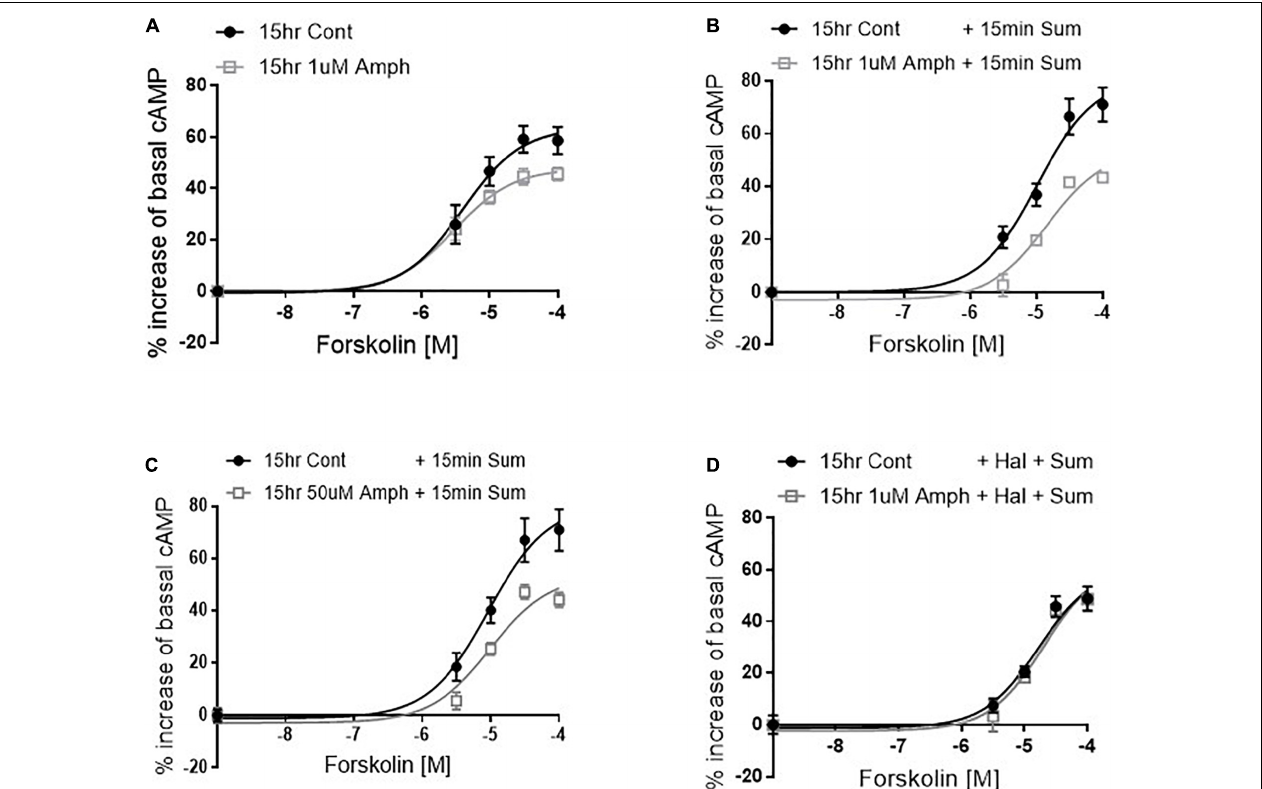
FIGURE 3 | Amphetamine reduces forskolin- and D2R-induced cAMP production. After pretreating cells with control or 1 µ M amphetamine (Amph), cells were treated with increasing concentrations of forskolin (A) . cAMP production was statistically lower in Amph-pretreated samples with respect to controls ( p = 0.006). Parallel samples were treated for 15 min with 100 µ M sumanirole (Sum) after 15-h pretreatment with control, 1 µ M (B) or 50 µ M (C) Amph. Amph significantly reduced cAMP production ( p = 0.0001). Coincubation of 10 nM haloperidol (Hal) with 1 µ M Amph prevented the Sum-induced decrease of cAMP (D) . Each graph is the average of 3 independent experiments. Statistical analysis was performed with 2-way ANOVA Bonferroni multiple comparison